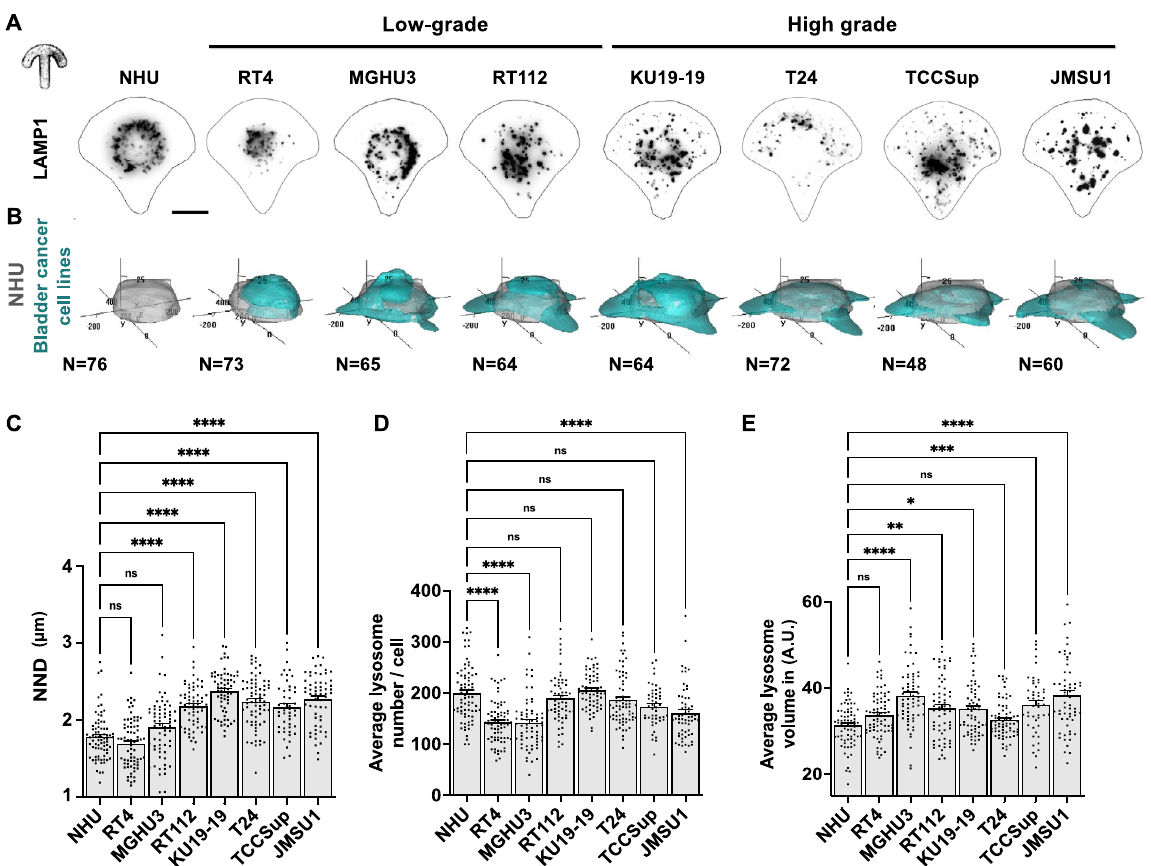
Fig. 1 High-grade cancer cell lines are speci fi cally characterized by scattered, peripheral positioning of lysosomes. A Representative images of lysosomes visualized by immuno fl uorescence staining against the lysosomal-associated membrane protein 1 (LAMP1/CD107a) in normal human urothelium (NHU) and bladder cancer cell lines RT4 (ATCC ® HTB-2 ™ ), MGHU3 70 , RT112 71 , KU19-19 72 , T24, TCCSup 73 , JMSU1 74 cells cultured on crossbow-shaped adhesive micropatterns for better comparison. Scale bar is 10 µ m. B 3D probabilistic density maps of lysosomes of N cells of NHU, RT4, MGHU3, RT112, KU19-19, T24, TCCSup and JMSU1. The 50% contour visualizes the smallest cellular volume containing 50% of lysosomes. C Nearest neighbor distance (NND) between lysosomes in NHU ( n = 76), RT4 ( n = 73), MGHU3 ( n = 65), RT112 ( n = 64), KU19-19 ( n = 64), T24 ( n = 72), TCCSup ( n = 48) and JMSU1 ( n = 60). Adjusted p values of testing against NHU condition are RT4: > 0.9999, MGHU3: 0.1943; RT112: < 0.0001; KU19-19: